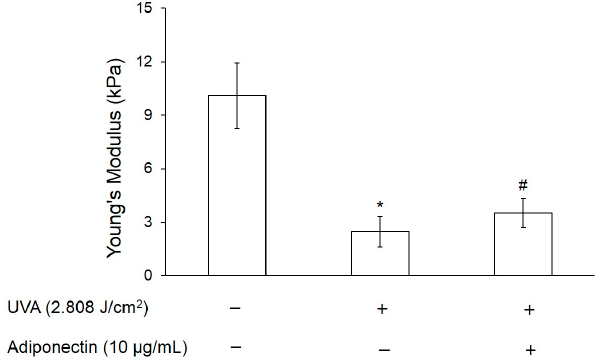
Figure 6. The effect of UVA radiation and adiponectin on the Young’s modulus of human dermal fibroblasts, Hs68. Young’s modulus was measured by AFM. Data were expressed by the mean of young’s modulus compared to control ±standard deviation, n = 25. * p < 0.05 with respect to control; # p < 0.05 with respect to cells treated with UVA radiation.